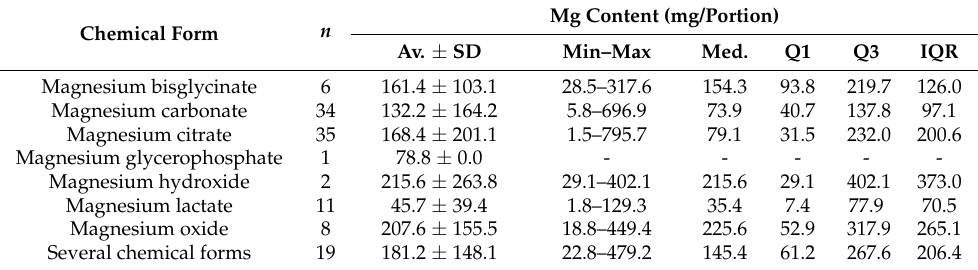
Table 3. Magnesium content (mg/portion) in food supplements depending on the chemical form.